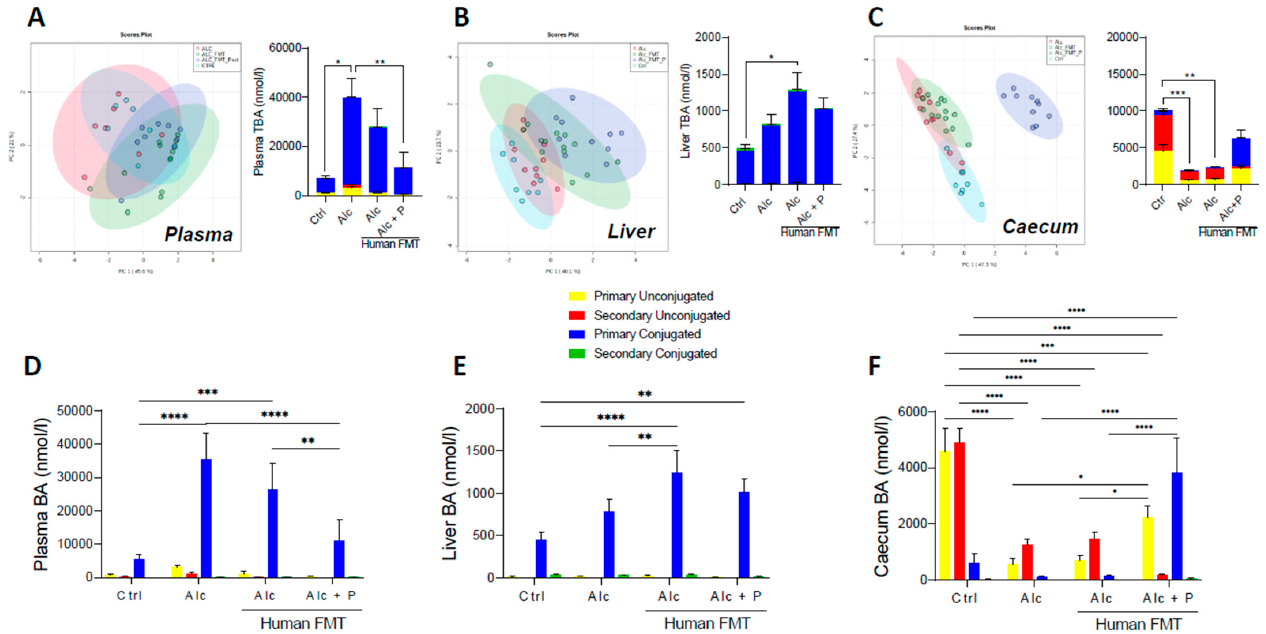
Figure 2. Pectin alters the bile-acid (BA) pool in different compartments. Control (Ctrl) and alcohol- fed (Alc) mice received a Lieber DeCarli diet with isocaloric maltodextrin or alcohol, respectively. Pectin-treated mice (Alc + p ) received 6.5% pectin in addition to 5% ethanol. Human fecal microbiota transfer (FMT) groups received microbiota from a patient with alcoholic hepatitis. PCA ordination plot on all BA and total BA (TBA) data in the plasma ( A ), the first component explained 45.6% of variance and the second one 21%, liver ( B ), the first component explained 40.1% of variance and the second one 23.7%, and caecum ( C ), the first component explained 47.3% of variance and the second one 27.4%. Light blue-Ctrl, red-Alc, green-Alc FMT, dark blue-Alc + p . Quantification of primary and secondary conjugated and unconjugated BAs in the plasma ( D ), liver ( E ), and caecum ( F ). * p < 0.05, ** p < 0.01, *** p < 0.001, **** p < 0.0001.